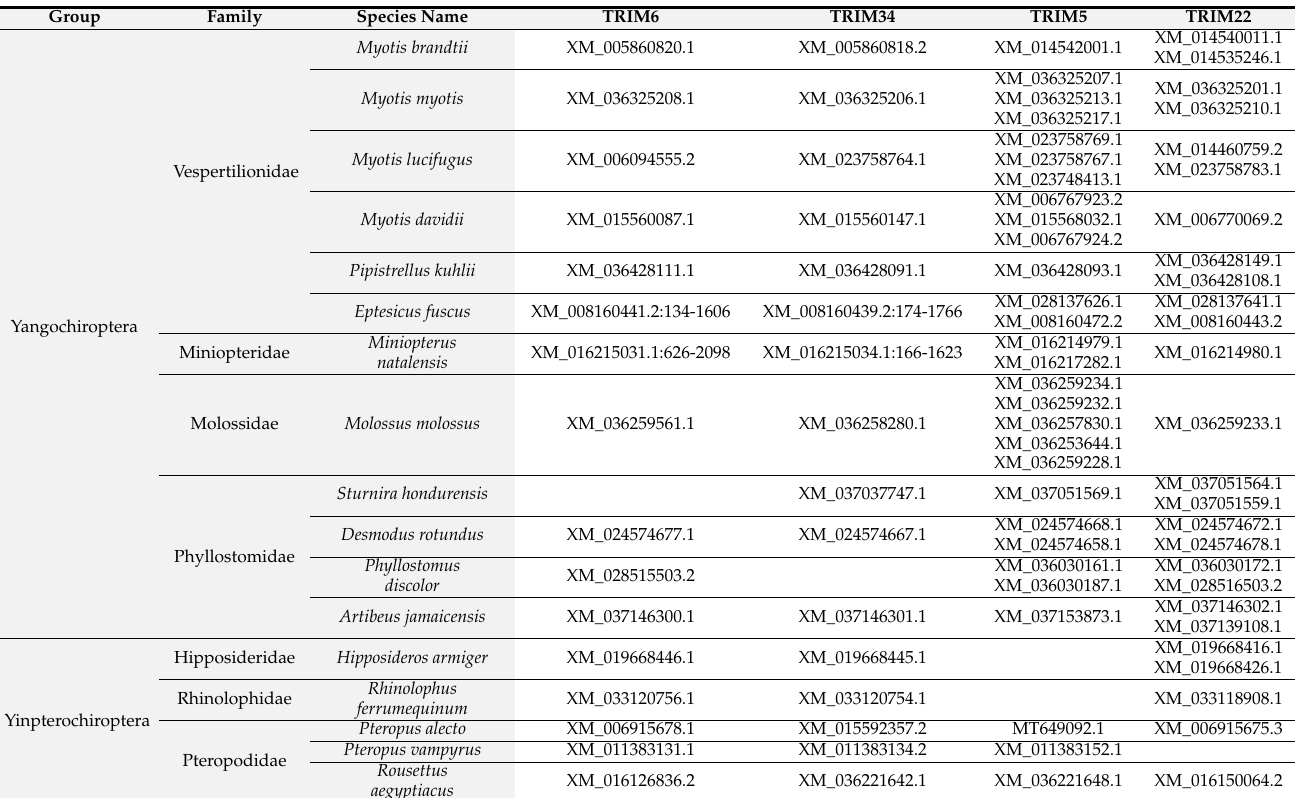
Table 1. Number of gene copies of TRIM6 , TRIM34 , TRIM5 , and TRIM22 found in different Chiroptera